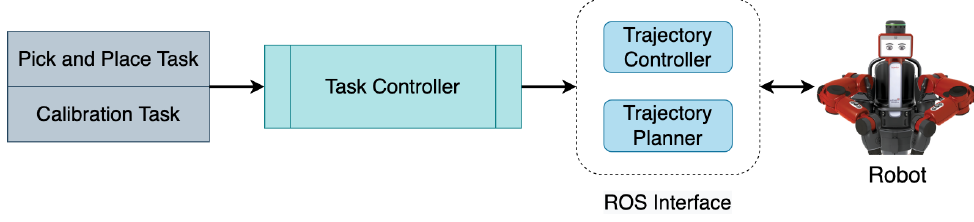
Figure 4. Control module uses the grasp poses generated by the inference module to plan and execute robot trajectories to perform antipodal grasps.